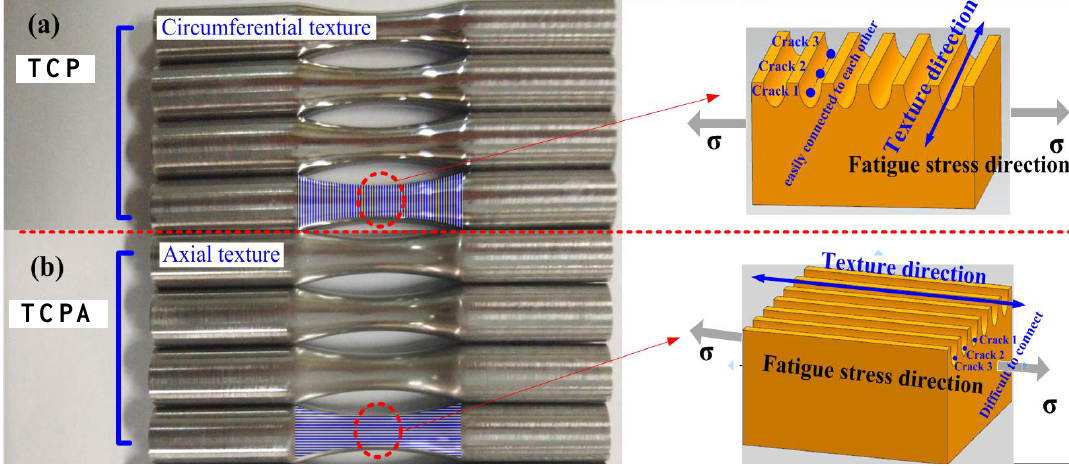
Figure 14. Relationship between fatigue stress direction and surface texture direction:( a ) TCP specimen and ( b )TCPA specimen.